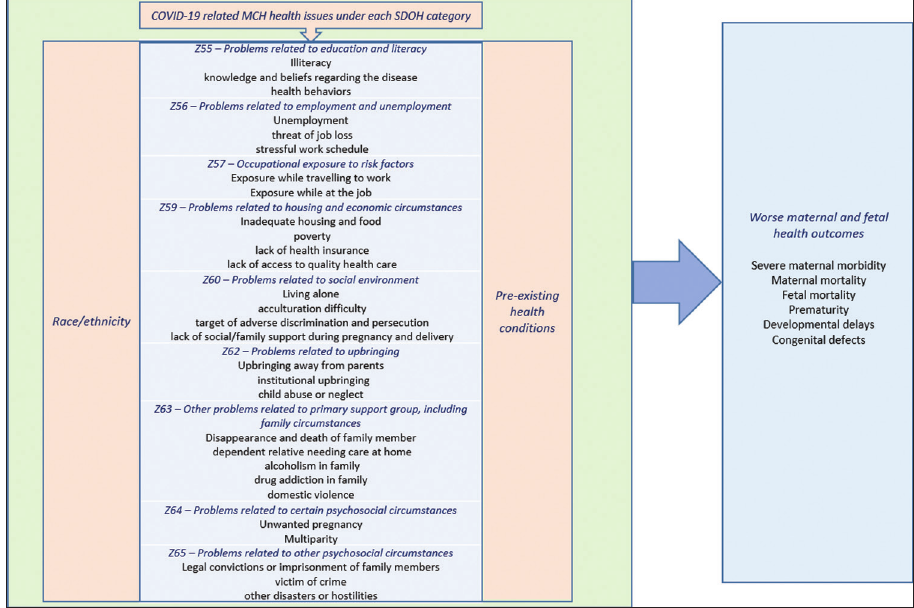
Figure 1: Conceptual model to describe the social determinants of health pathways contributing towards disparities and worse outcomes in the MCH population during the COVID-19